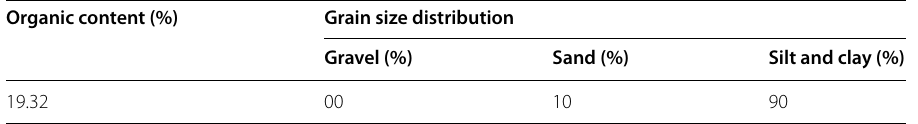
Table 3 Properties of sludge